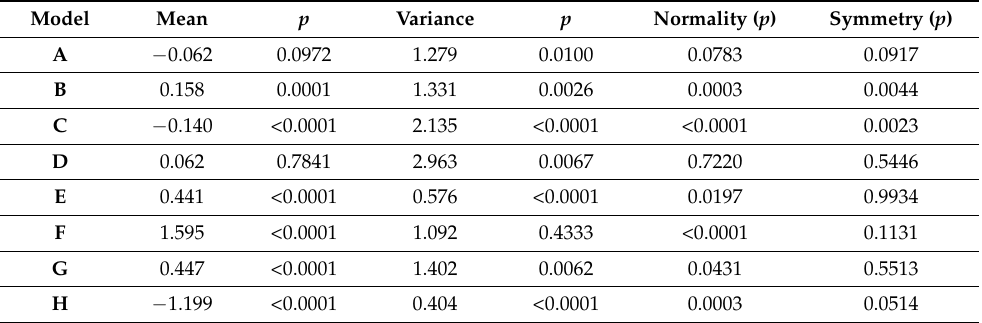
Table 4. Mean, variance, and results of normality and symmetry tests of the NDPE distribution for the 8 evaluated